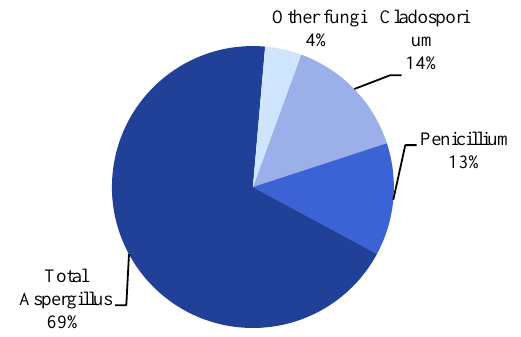
Figure 4. Percentage of fungi isolated in old water distribution